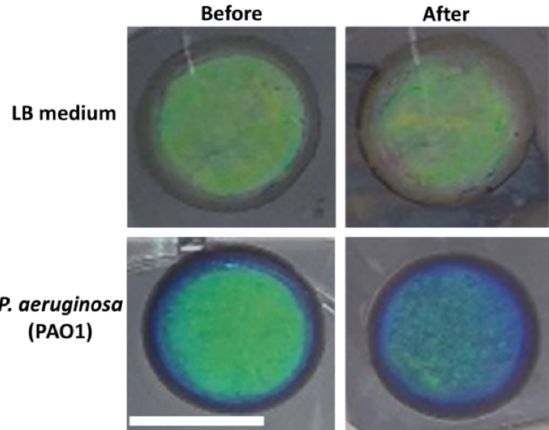
Figure 8. Photographs of the pre ‐ dried PLA ‐ coated pSiRF before and after the immersion in bacte ‐ ria ‐ free LB medium and in P. aeruginosa (PAO1) suspension (bacteria starting concentration: 1.9 × 10 9 CFU.mL − 1 ) in LB medium at 37 °C for 24 h (end concentration: 3.7 × 10 9 CFU.mL − 1 ), scale bar = 1 cm.